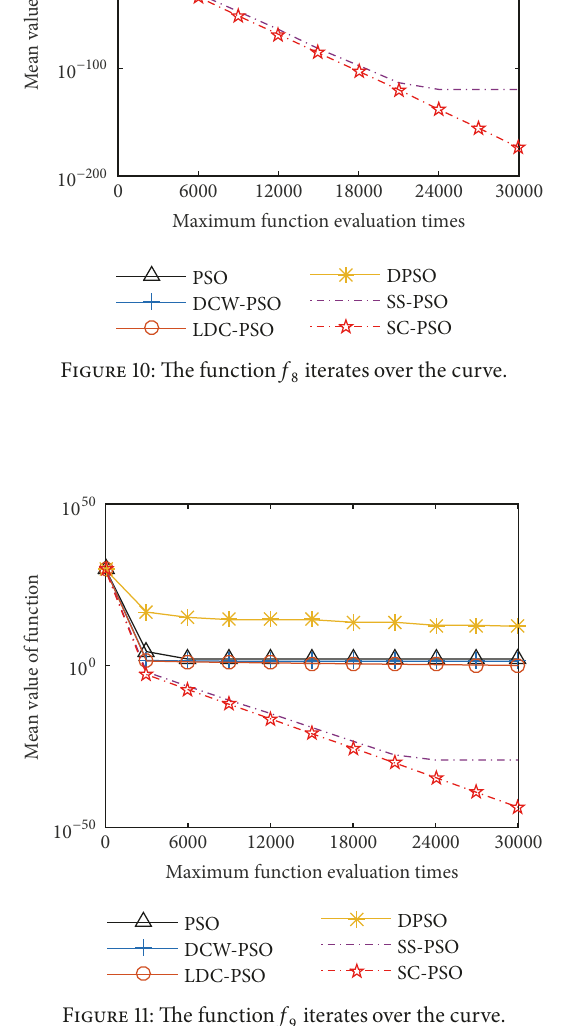
means that the speed of SC-PSO is the faster. Compared with PSO, SC-PSO’s average runtime is 0.7725 s, while PSO’s is 2.1244s, and SC-PSO’s average runtime is 36% of PSO’s. Compared with the other 4 algorithms, SC-PSO’s average runtime accounts for 34%, 37%, 20%, and 43% of DCW-PSO’s (2.2871s), LDC-PSO’s (2.0658s), DPSO’s (3.8148s), and SS- PSO’s (1.7965s), respectively.